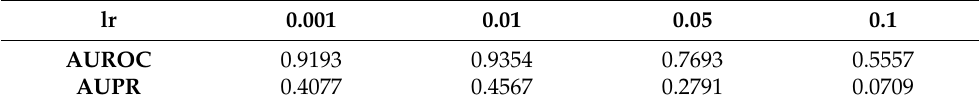
Table 4. AUROC and AUPR at a different learning rate.